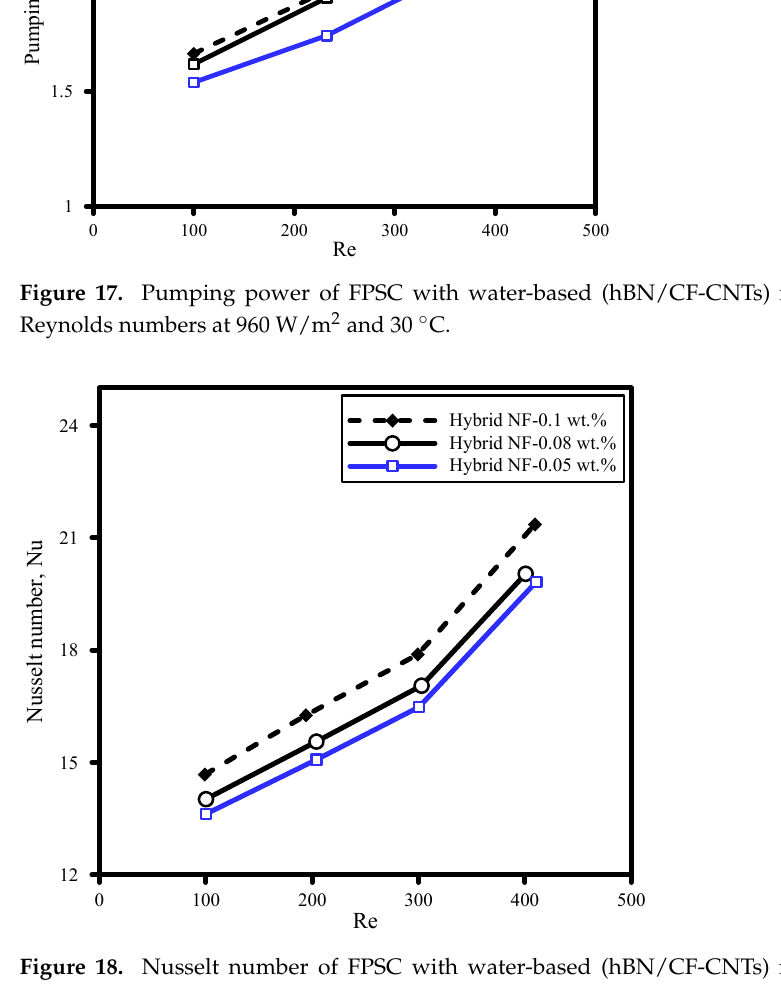
Figure 18. Nusselt number of FPSC with water-based (hBN/CF-CNTs) nanofluid for various Reynolds numbers and different weight